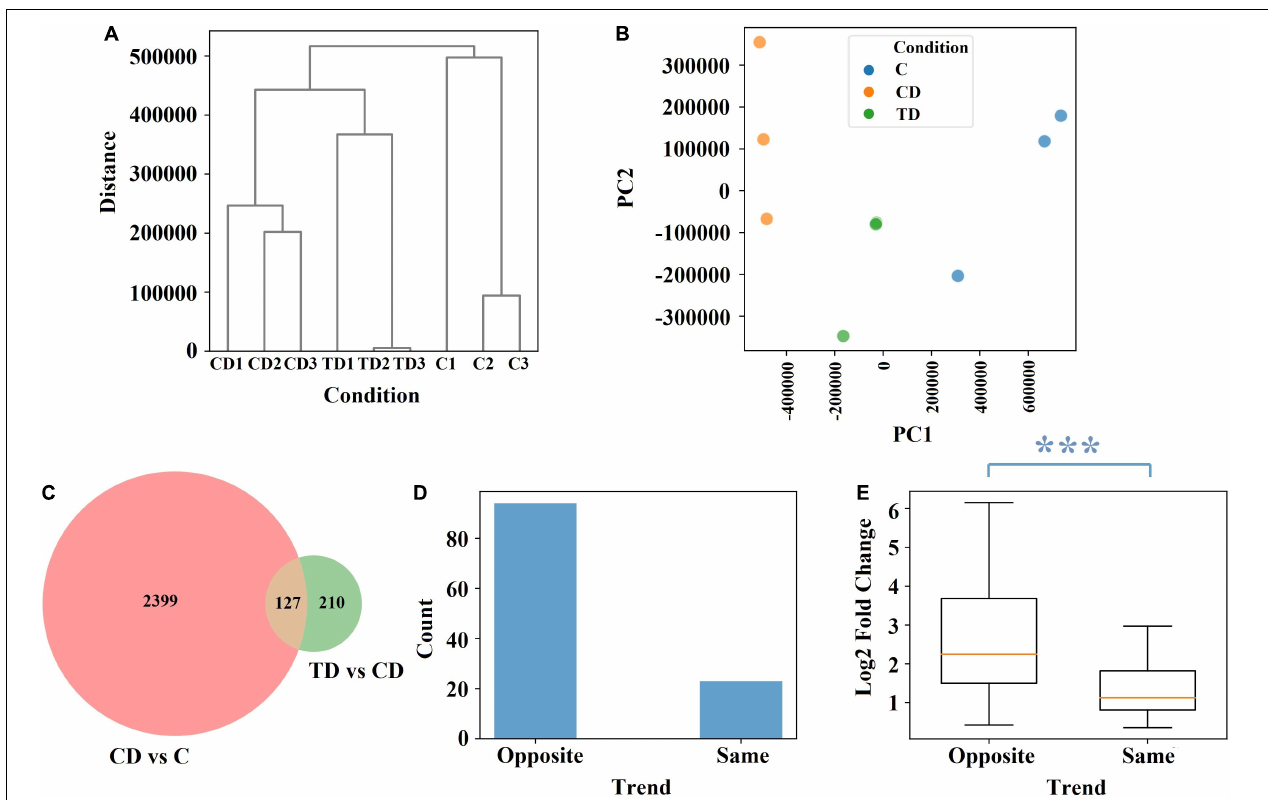
FIGURE 5 | The effect of Tibetan tea at the genetic level. (A) Hierarchical clustering dendrogram of normalized gene expression. (B) Principal component analysis of normalized gene expression. (C) Venn diagram of the differential expression between CD vs . C and between TD vs . CD. (D) Trend count of 127 common genes. (E) Log2 fold change of the 127 common genes. The difference between the two trends is characterized using the Mann–Whitney U test p -value. *** p < 0.005. TD , Tibetan tea + DSS; CD , dextran sodium sulfate-induced model; C ,